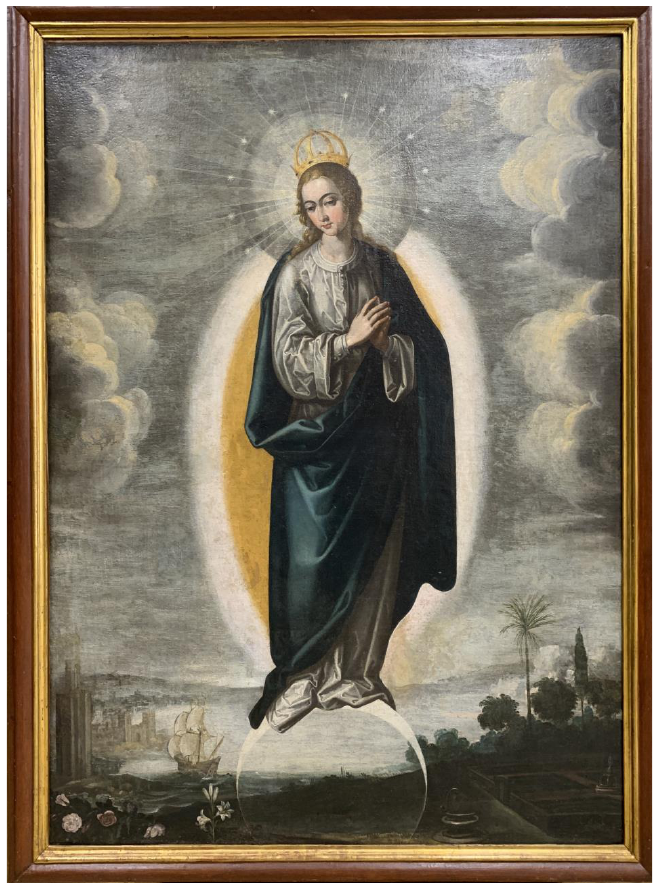
Figure 1. Francisco Pacheco: La Inmaculada , 1610, Archbishop’s Palace, Seville.